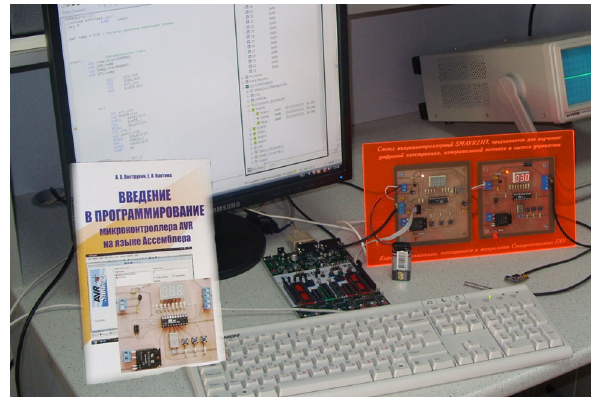
Figure 3. Educational resource for programming